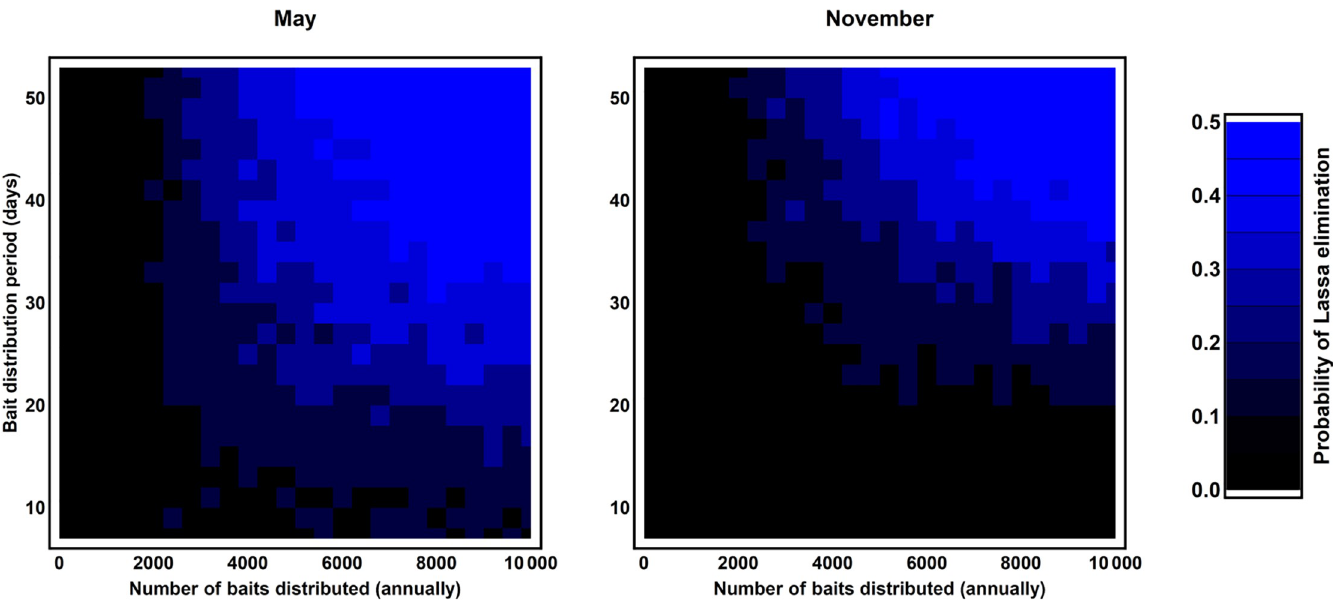
Fig 7. The proportion of simulated vaccination campaigns resulting in the simultaneous elimination of Lassa virus from the villages of Bantou and Tanganya as a function of the number of vaccine-laced baits distributed per year (x axis) and the duration of bait distribution (y axis). The left-hand column shows results for campaigns where vaccination occurs in May when birth rates are minimized (bait distribution begins May 1 of each year). and the right hand column campaigns where vaccination occurs in November when birth rates are maximized (bait distribution begins November 1 of each